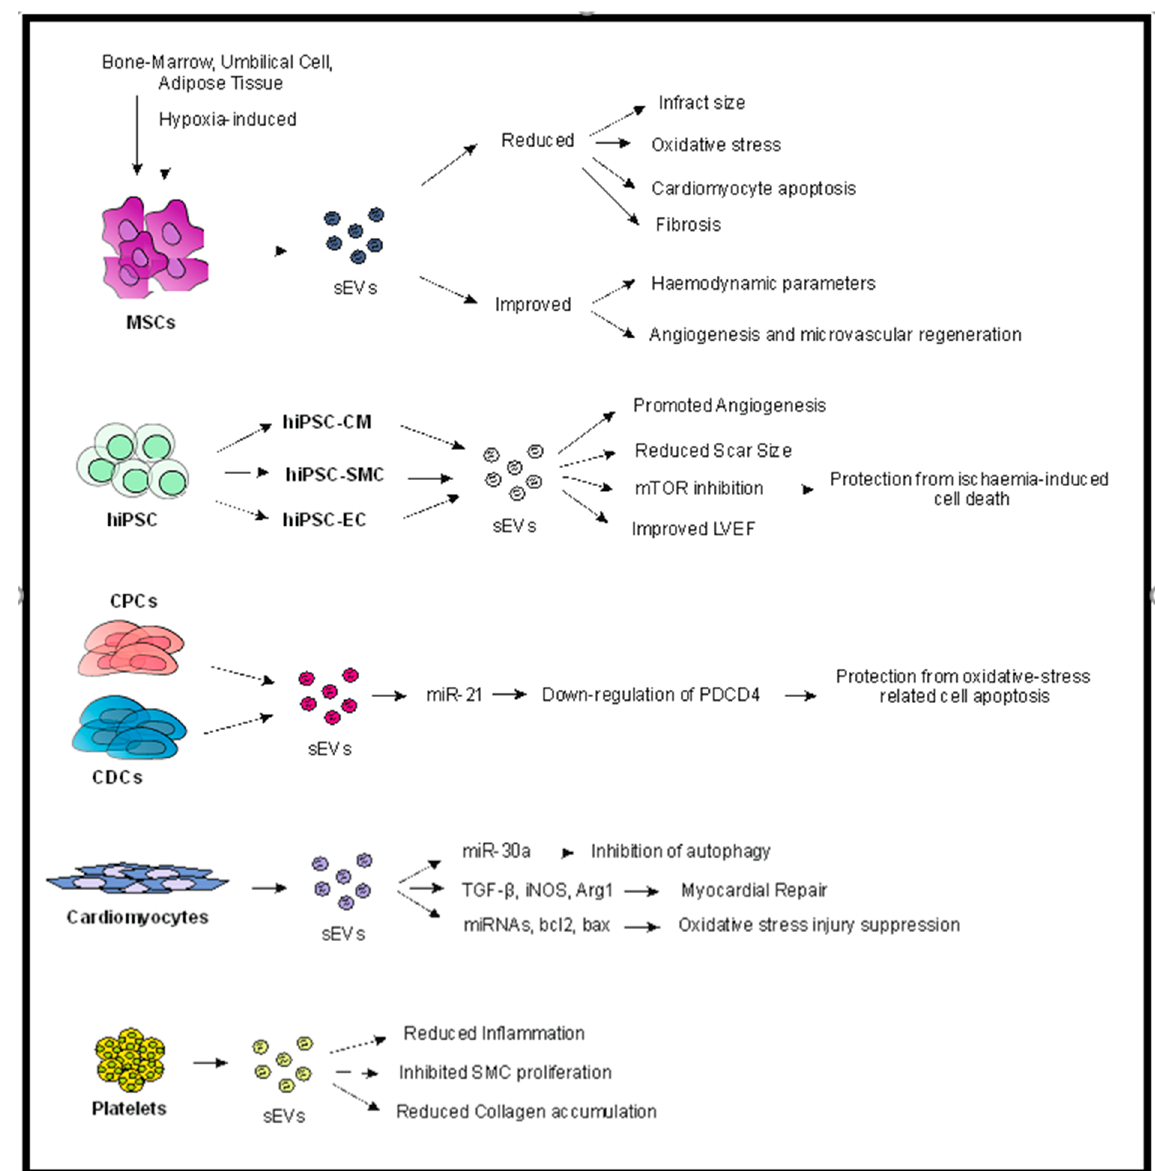
Figure 1. Potential contribution of sEVs in myocardial protection. As demonstrated, sEVs may be derived from various types of cells, such as MSCs (of any source), hiPSC, CPC and CDC, cardiomyocytes, and platelets. Different mechanisms of action have been proposed for the various sEV groups, although common pathways and mechanisms are identified, such as reduced cardiomyocyte apoptosis and fibrosis and increased angiogenesis, which contribute to reduced infract size and improved hemodynamic parameters. Abbreviations: sEVs: small extracellular vesicles, hiPSC: human induced-pluripotent stem cells, CM: cardiomyocytes, SMC: smooth muscle cell, EC: endothelial cell, LVEF: left ventricular ejection fraction, CPCs: cardiac progenitor cells, CDCs: cardiosphere-derived cells, PDCD4: programmed cell death 4.